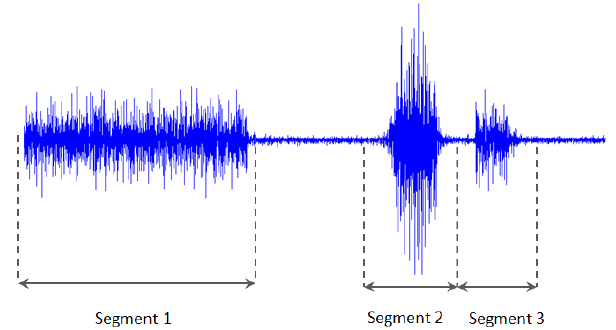
Figure 9. Segmentation of the EMG signal.